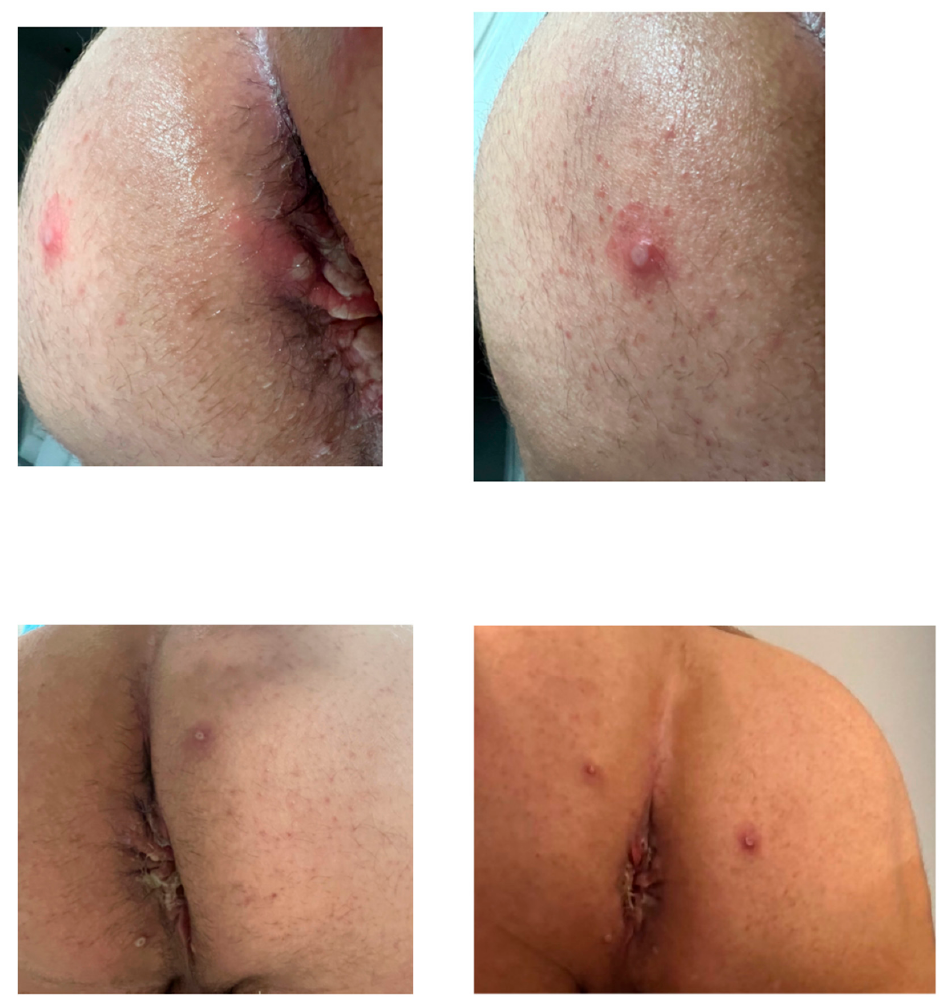
Figure 1. Lesions of perianal region, patient 1. Top row represents day 5 from symptom onset; bottom row was captured on day 8.